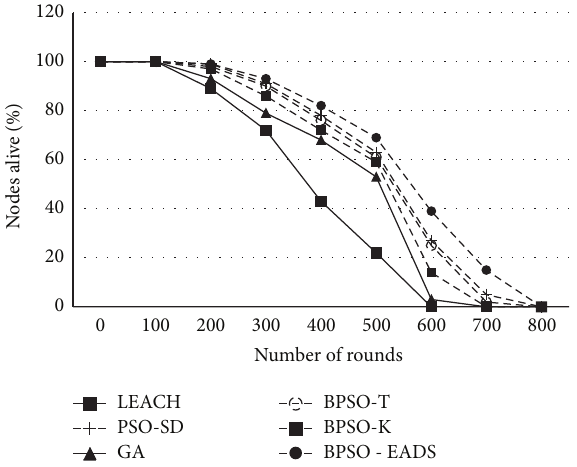
Figure 8: Number of nodes alive across various rounds.